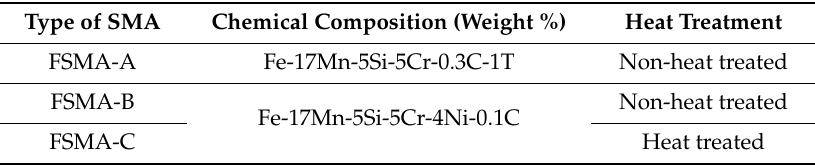
Table 1. Chemical composition of